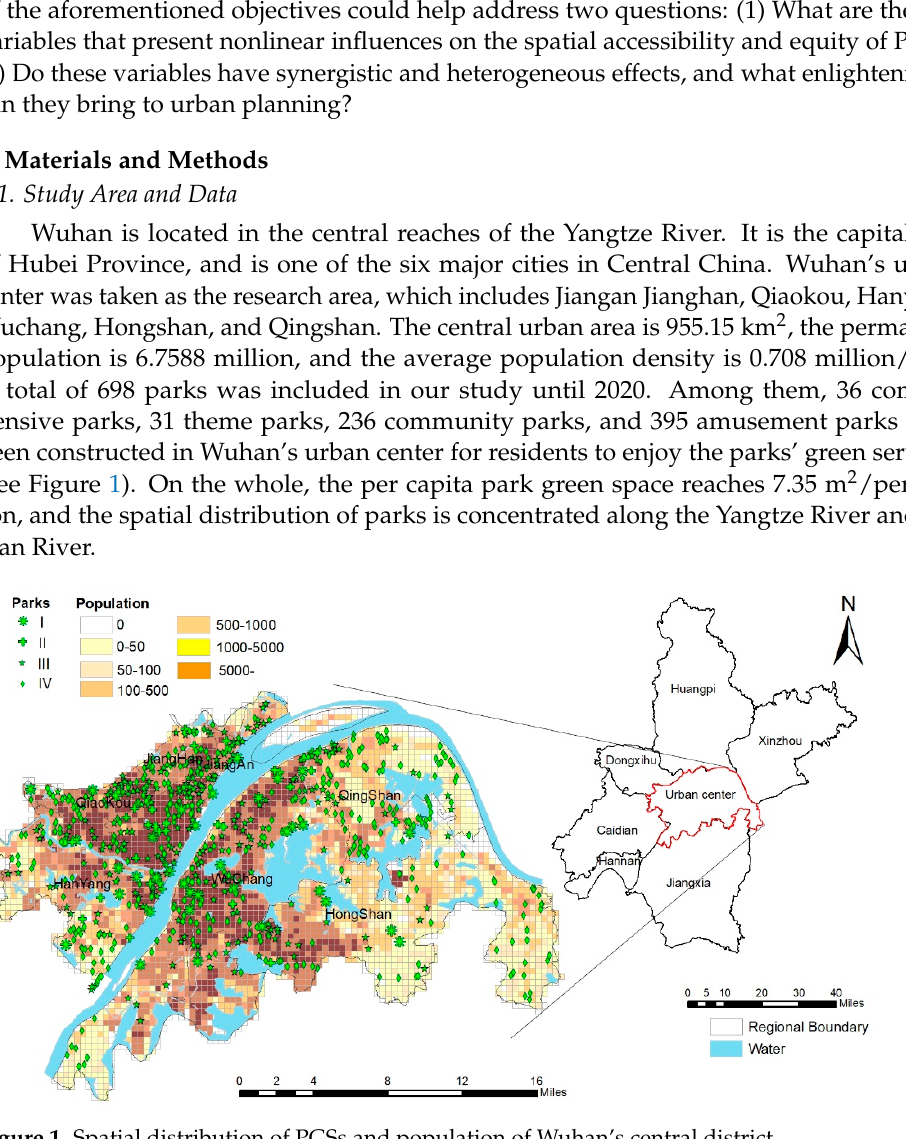
Figure 1. Spatial distribution of PGSs and population of Wuhan’s central district.